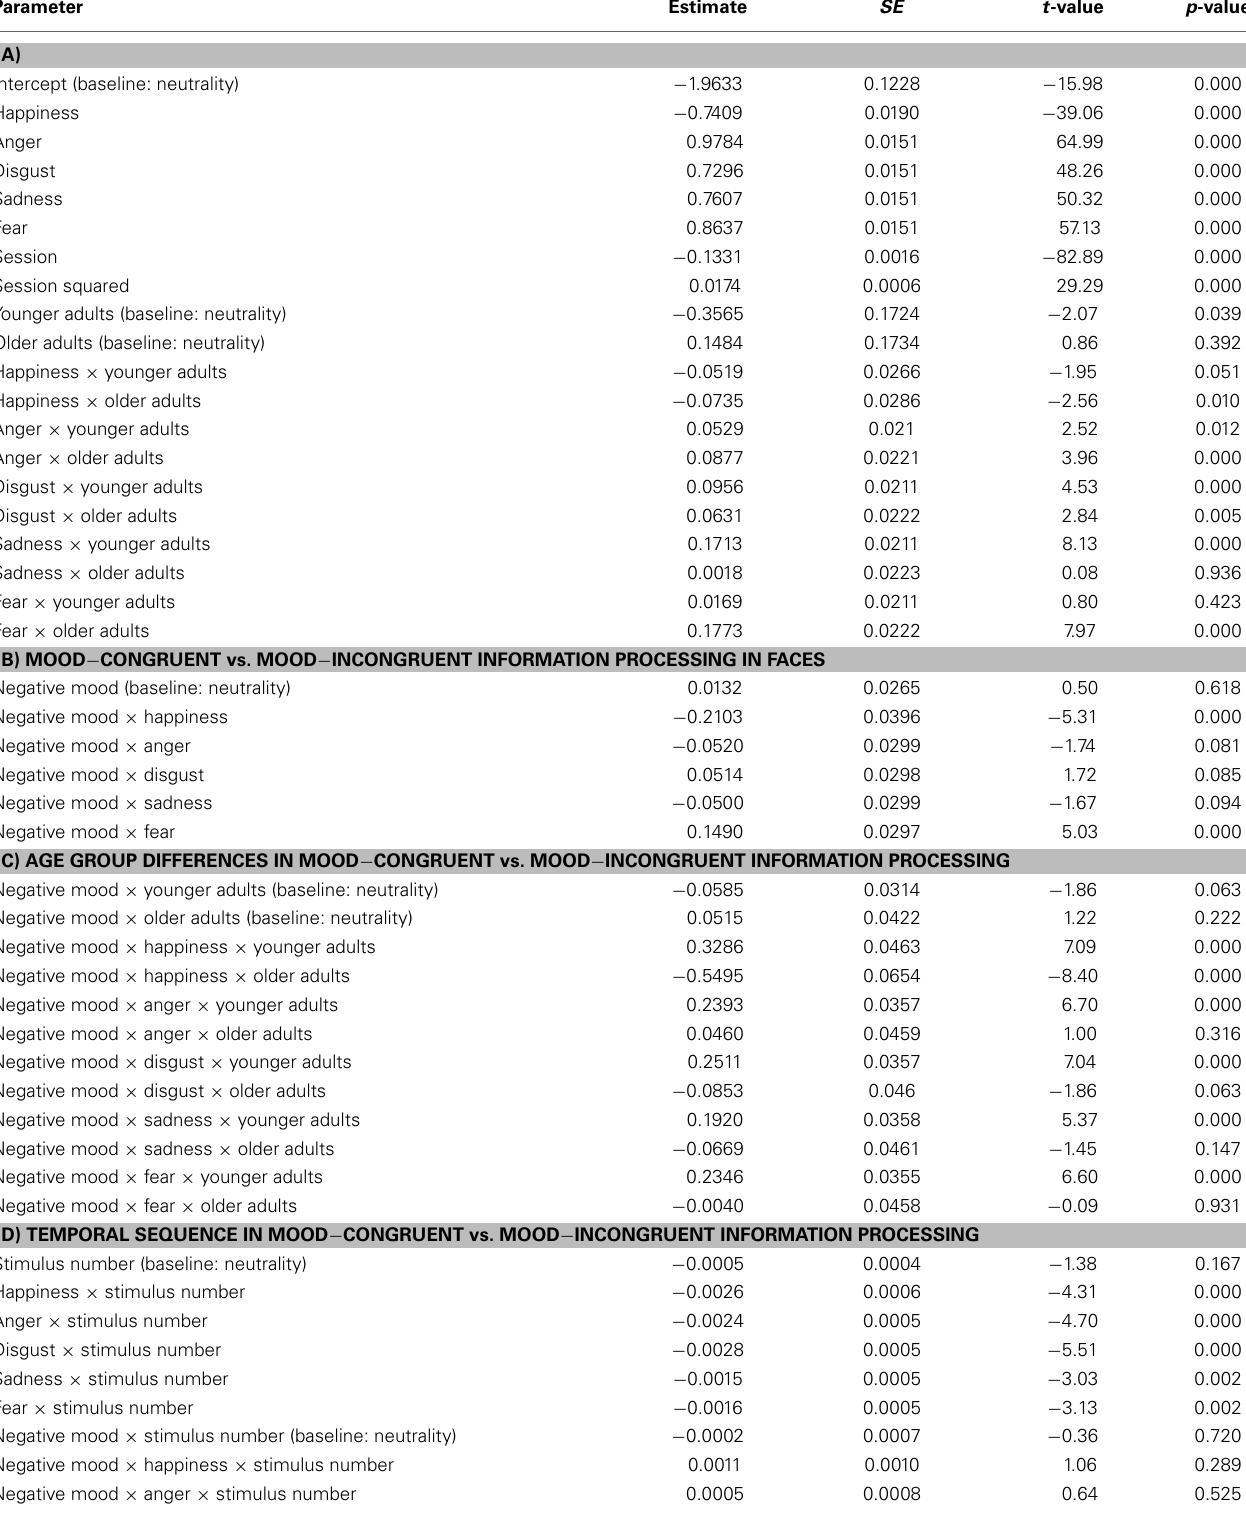
Table 2 | Results of a crossed random effects analysis predicting the likelihood of perceiving an (additional but the primary) emotional expression in a face by type of emotion, negative mood, session number, stimulus number, and age group. Parameter